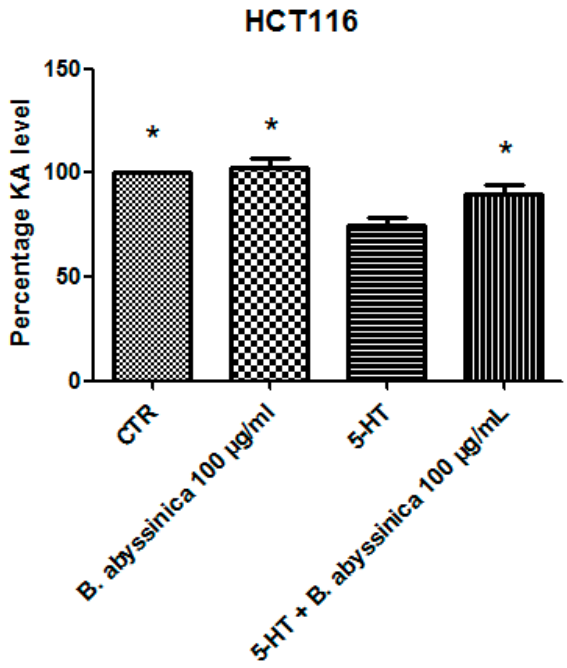
Figure 3. Blunting effect induced by B. abyssinica water extract 100 μ g/mL on serotonin (5-HT)-induced reduction of kynurenic acid (KA) release from colon cancer HCT116 cells. Data are means ± SD and analyzed through analysis of variance (ANOVA), followed by post hoc Newman–Keuls test. ANOVA, p < 0.01; post hoc , * p < 0.05 vs. 5-HT (serotonin) group. The B. abyss. 100 μ g/mL group reported in the picture was compared to the sole CTR group ( p > 0.05).